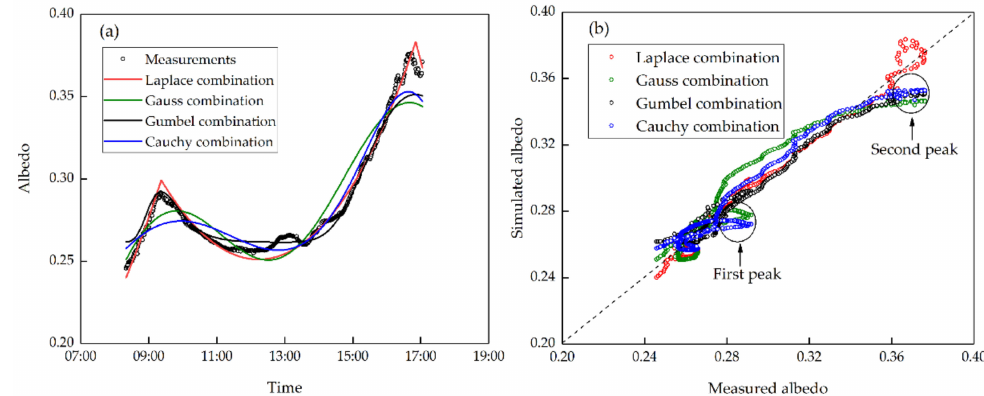
Figure 4. The simulated albedo curves of the four combined statistical models for 29 January: ( a ) the daily variation of the albedo; ( b ) the comparison of the measured albedo with the simulated albedo. The Gumbel combination was a good fit for the first peak in terms of value and position, but a relatively poor fit for the second peak. The simulated second peak was lower and earlier than the actual measurement. In addition, the trough simulated by the Gumbel combination was flatter around solar noon. The Laplace combination fitted the observed albedo curve best. The simulated peaks had a sharp shape, resembling the measured peaks only with slight overestimates, as there is a sharp peak in the curve of Laplace function itself. The simulated positions of peaks also corresponded accurately. The simulated curve between the two peaks was also close to the actual